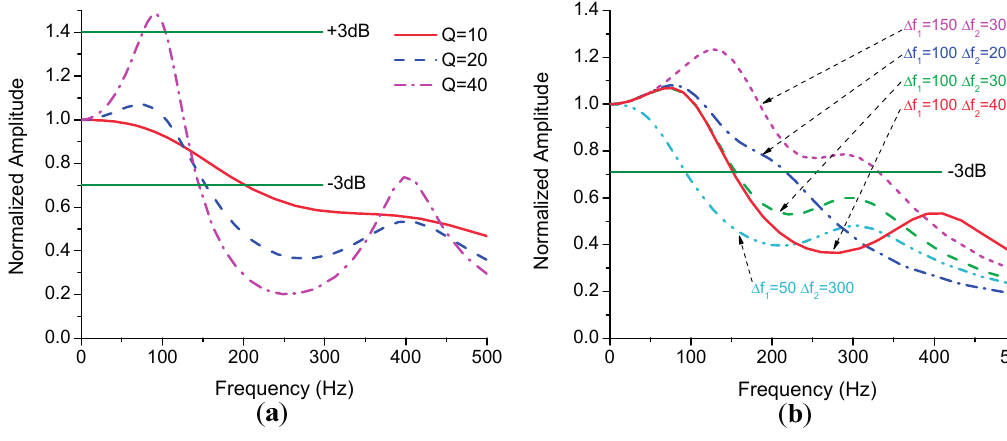
Figure 7. ( a ) The frequency responses with different Q ; ( b ) The frequency responses with variations of frequency